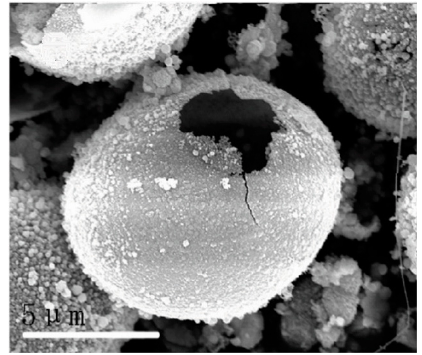
Figure 2. SEM image of as-prepared β -SiC [66].